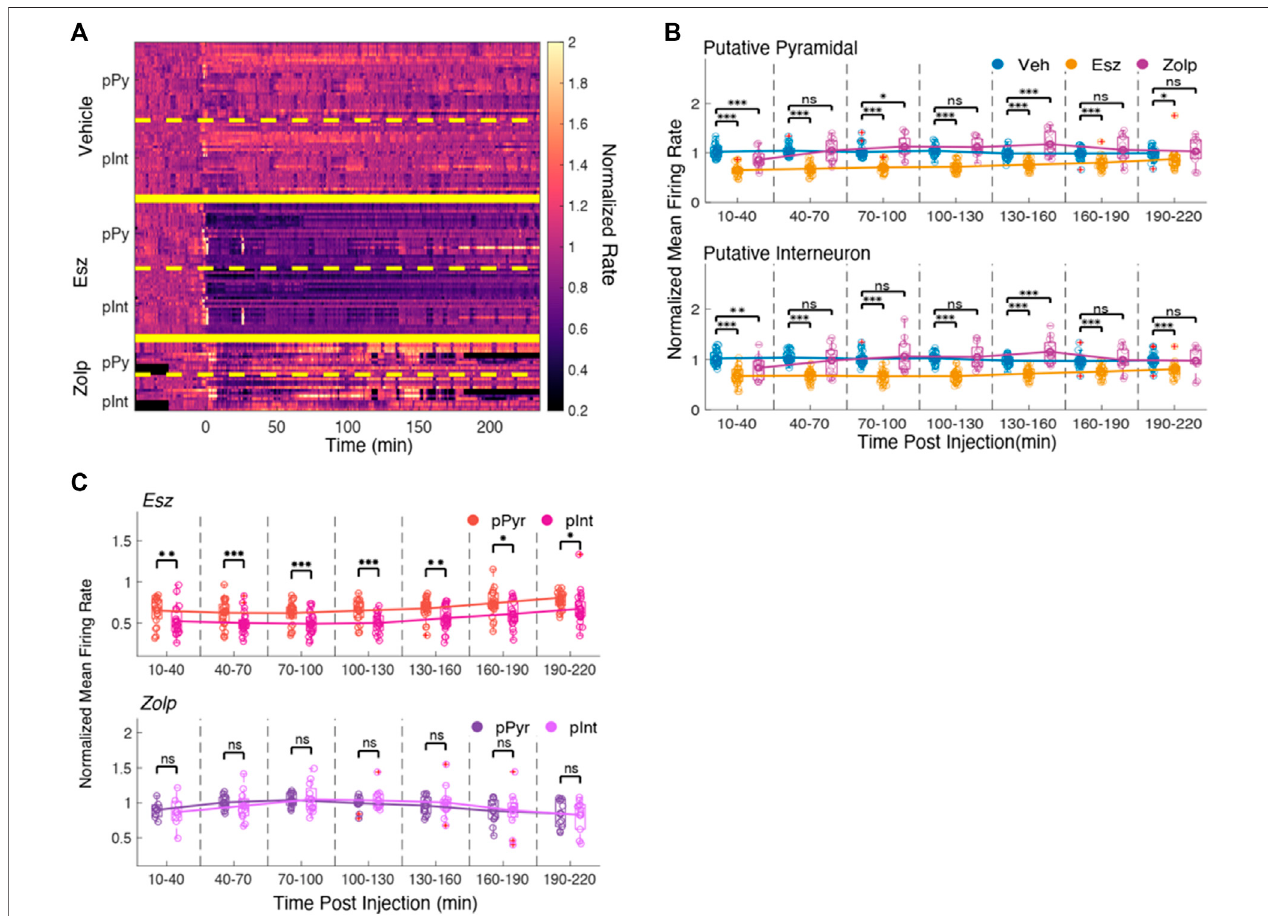
FIGURE 4 | Eszopiclone and zolpidem have similar effects on spikes from putative pyramidal cells and interneurons. (A) Smoothed histograms of spike rate normalized by average rate during the ‘ baseline ’ time period for putative pyramidal cell spikes (pPy) and putative interneuron spikes (pInt). Rate matrix is divided into vehicle (top) ,eszopiclone (middle) and zolpidem (bottom) ,and furtherseparatedintoputative pyramidalcellsandputative interneurons ( n (cid:1) 4rats). (B) Boxplotsofthe normalized mean spike rates for putative pyramidal cell (top) and putative interneuron spikes (bottom) in 30-minute time intervals post-injection with line connecting the means of each drug type. Each circle one tetrode; red crosses indicate outliers. Signi fi cance was determined using an F-test on a fi tted mixed linear model. (C) Boxplots comparing side by side the effect on the peri-ripple histograms for putative pyramidal and putative interneuron spikes in eszopiclone (top) and zolpidem sessions (bottom) . Peri-ripple rates (normalized to baseline) are binned every 30 min post-injection with lines connecting the means. Signi fi cance was determined using an F-test on a fi tted mixed linear model.